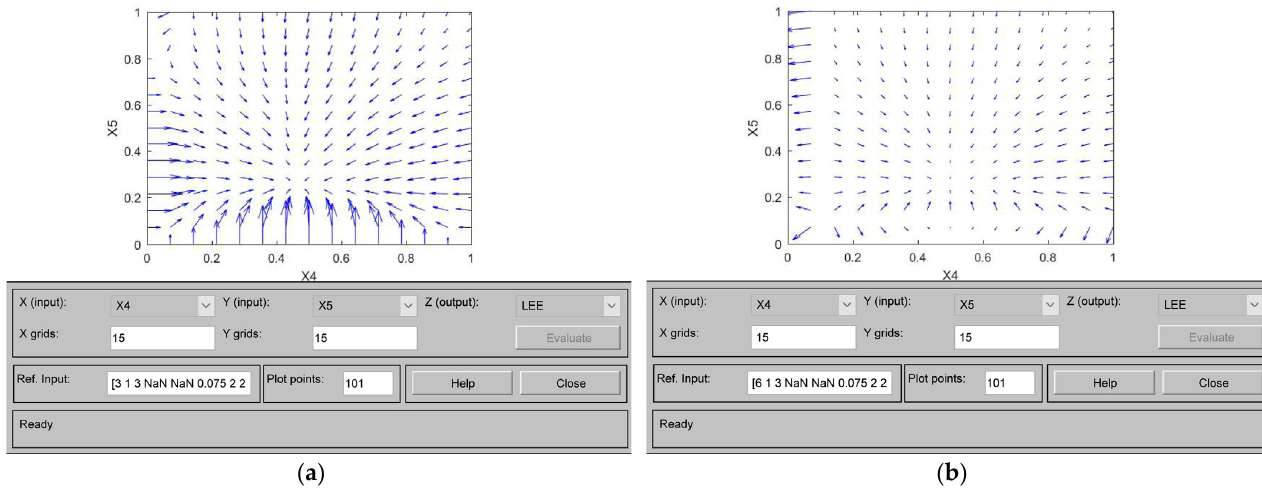
Figure 6. Dependence of LEE (x 4 ,x 9 ) on the degree of use of load capacity (x 4 ) and time interval (x 9 ) for vehicle of category N2.